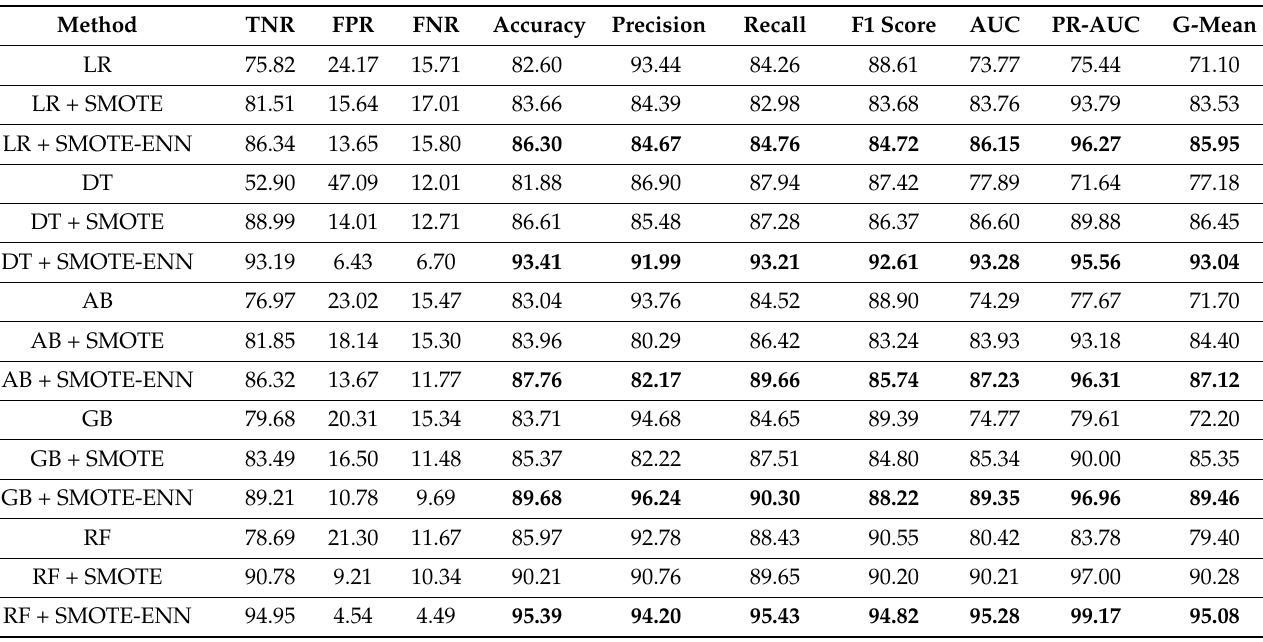
Table 3. Results for H1 hotel.